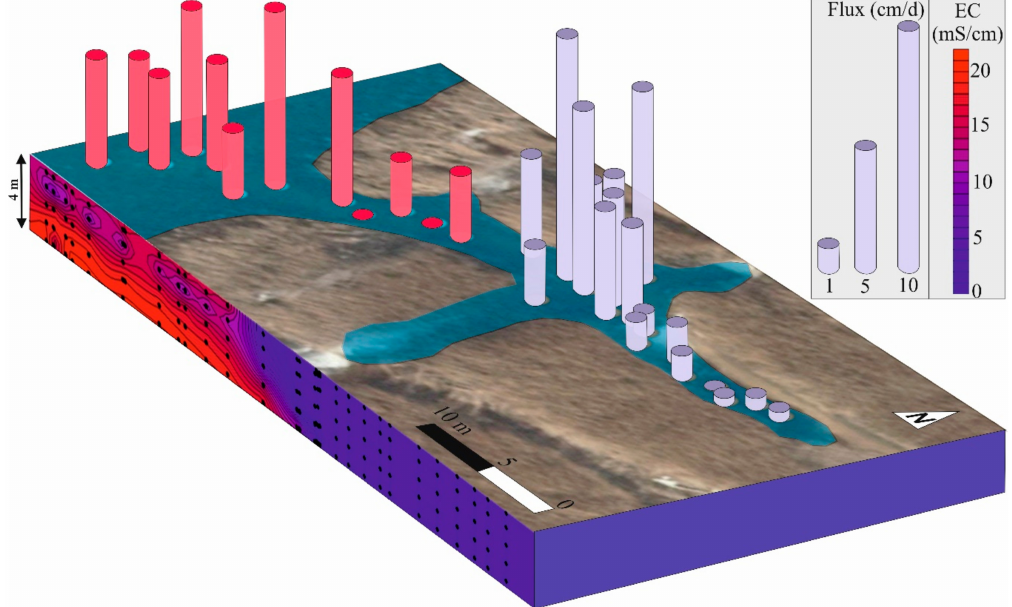
Figure 3. Spatial plot of discharging fluxes measured with seepage meters and an interpolation of measured EC in collected groundwater. The red / purple colors of the flux bars indicate if the mass balance of the seepage meters bags showed fresh ( < 10 mS / cm) or saline water ( > 10 mS /